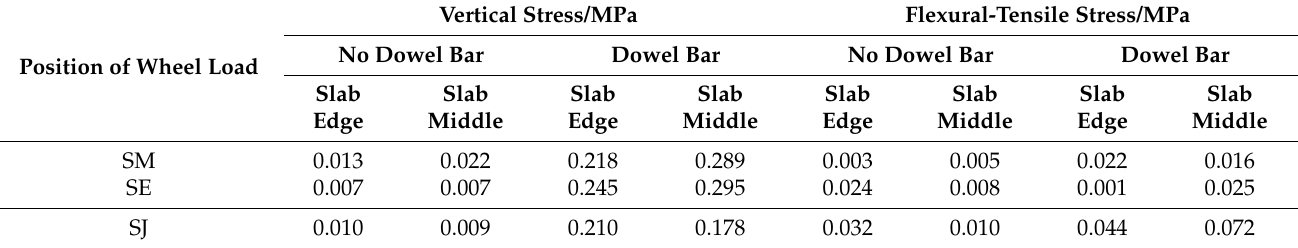
Table 4. Stress values at different positions of